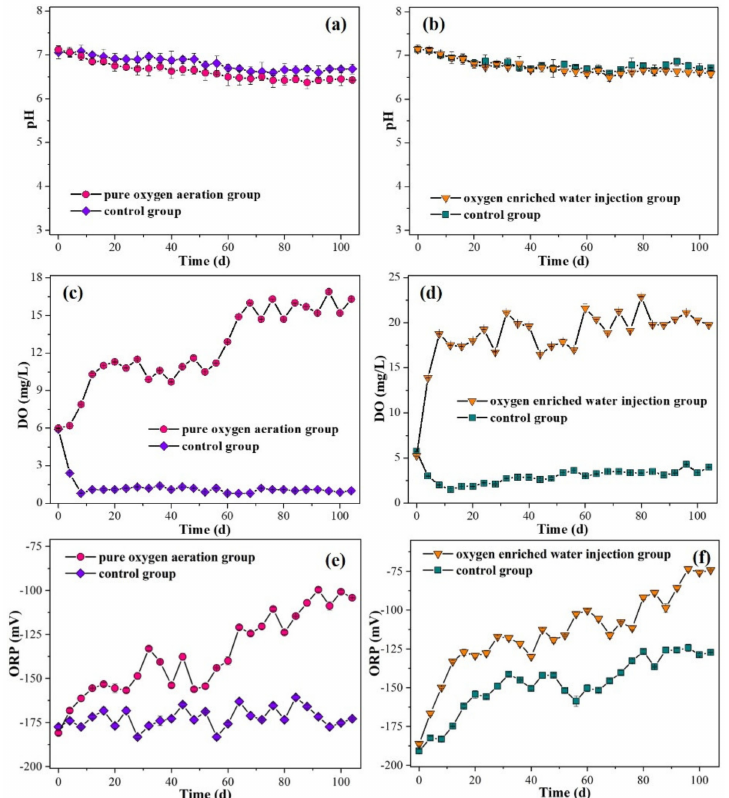
Figure 4. The e ff ects of ( a ) pure oxygen aeration treatment and ( b ) oxygen enriched water injection treatment on the pH of the sediment; the e ff ects of ( c ) pure oxygen aeration treatment and ( d ) oxygen enriched water injection treatment on the dissolved oxygen (DO) concentration in the sediment; the e ff ects of ( e ) pure oxygen aeration treatment and ( f ) oxygen enriched water injection treatment on the ORP in the